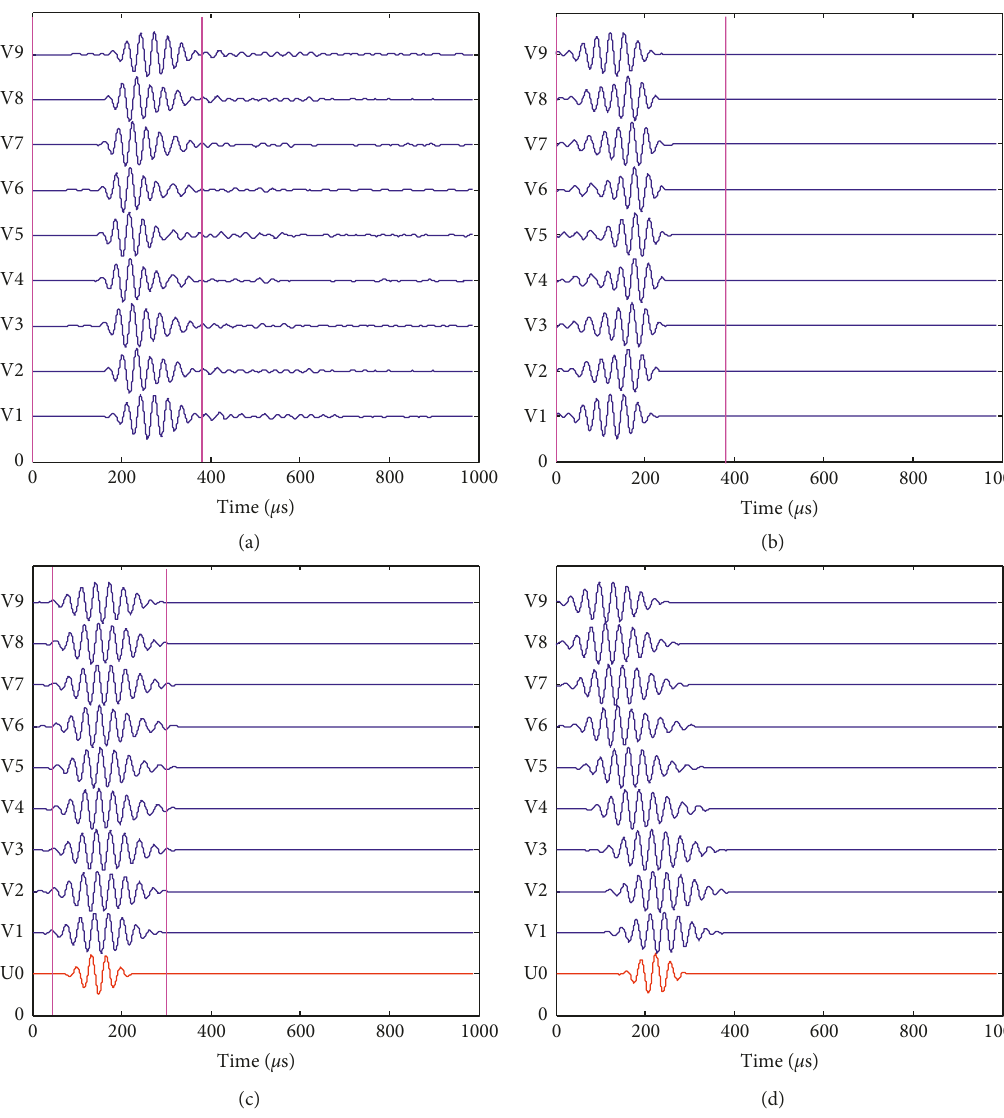
Figure 7: Focusing of the direct and adjoint sound fields at the defect: (a) scattered signals received by all receiving sensors; (b) scattered signal after time reversal; (c) scattered signals reaching the defect; (d) scattered signals reaching the nondefective